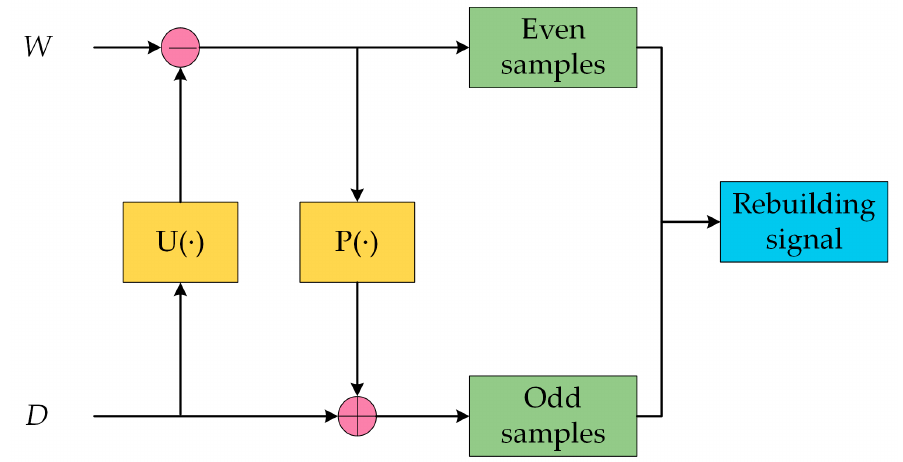
Figure 6. The second ‐ generation wavelet transformation: a sketch map of reconstruction.